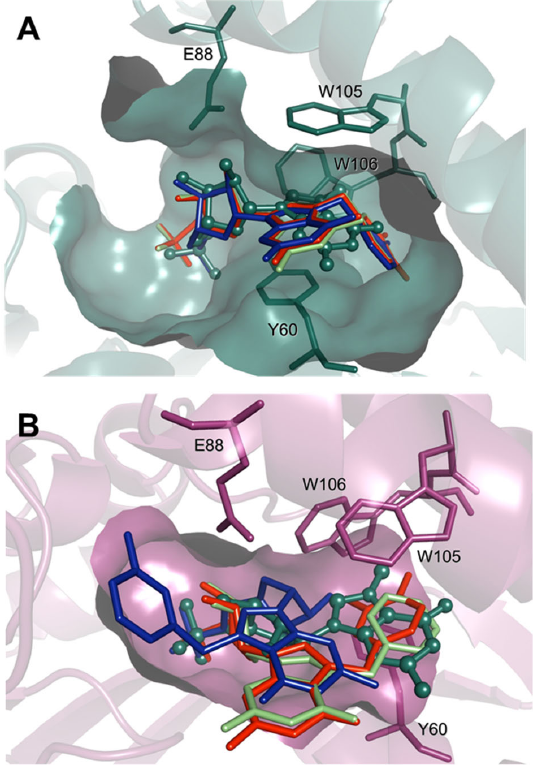
Figure 7. Comparison of the top docking poses of compounds 5 (lime), 5a (blue), and 5d (red) in the open ( A ) and closed ( B ) enzyme conformations. The substrate, m 7 GMP, is shown as a reference in ball ‐ and ‐ stick representation (green). For clarity, only heavy atoms and selected pocket residues are shown.